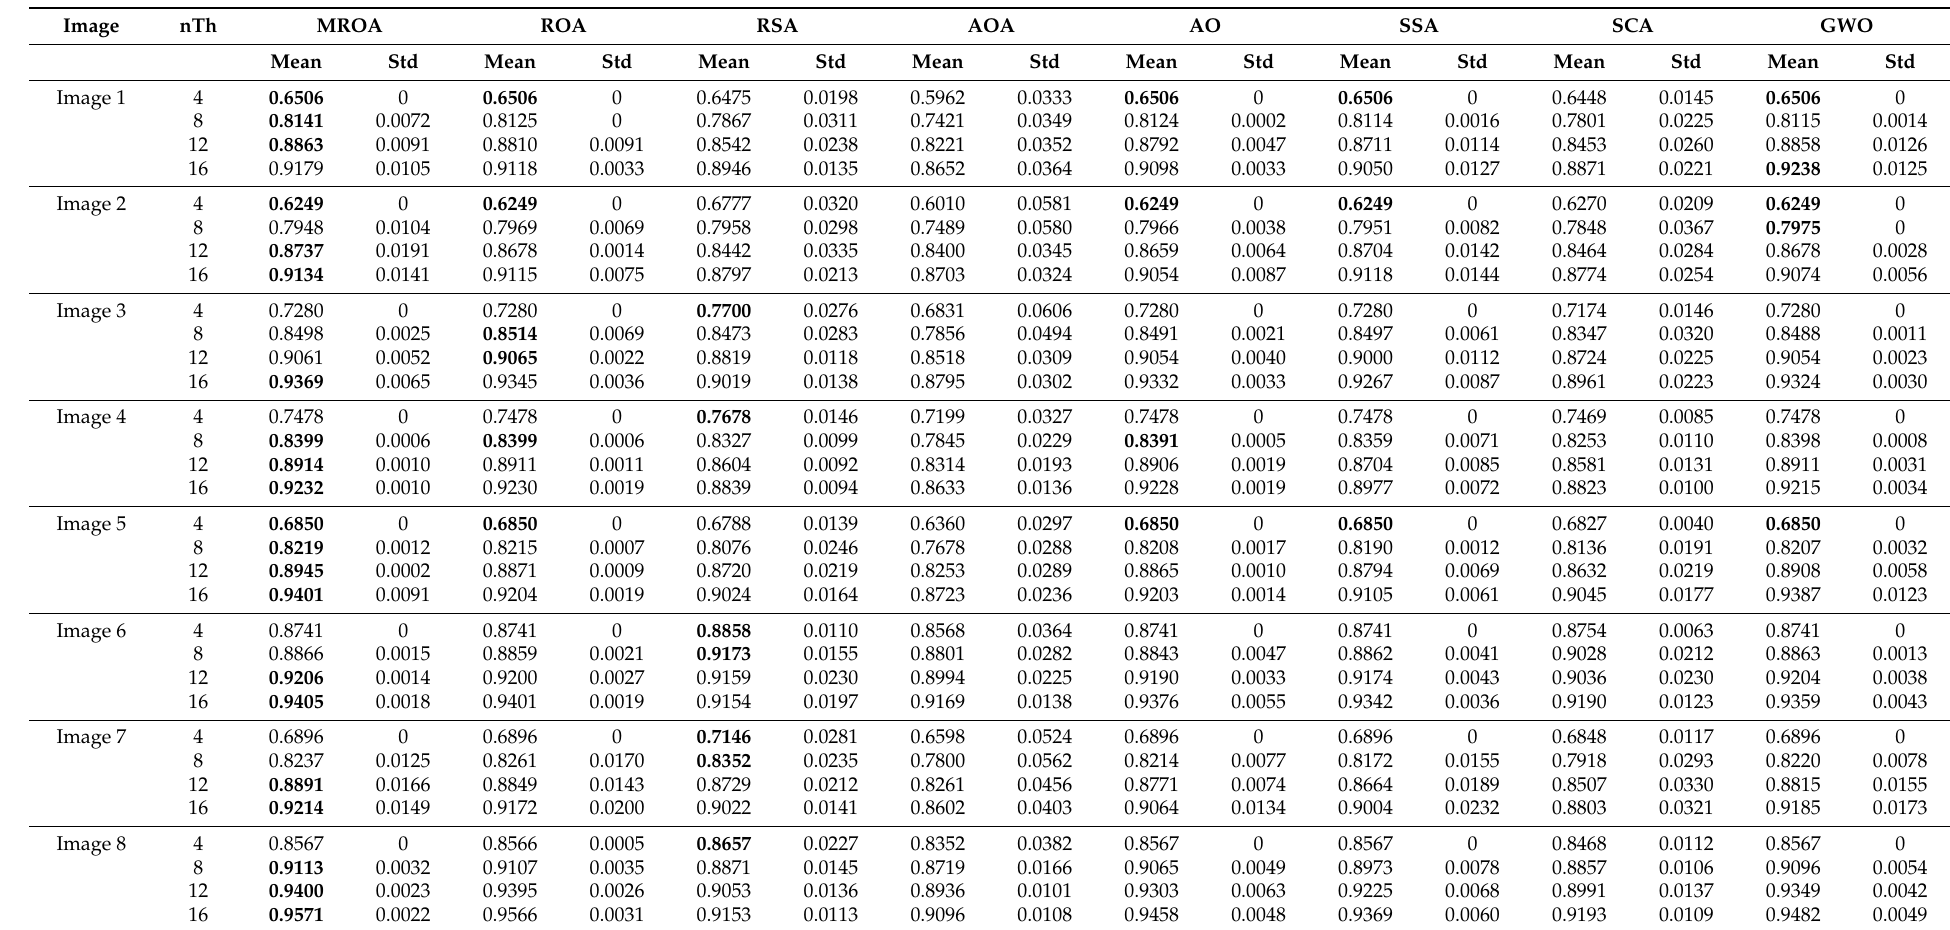
Table A5. The SSIM values obtained by algorithms over all